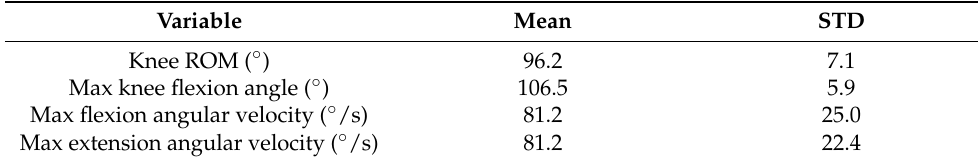
Table 1. Kinematic characteristics of the movements ( n = 15, five subjects x three load